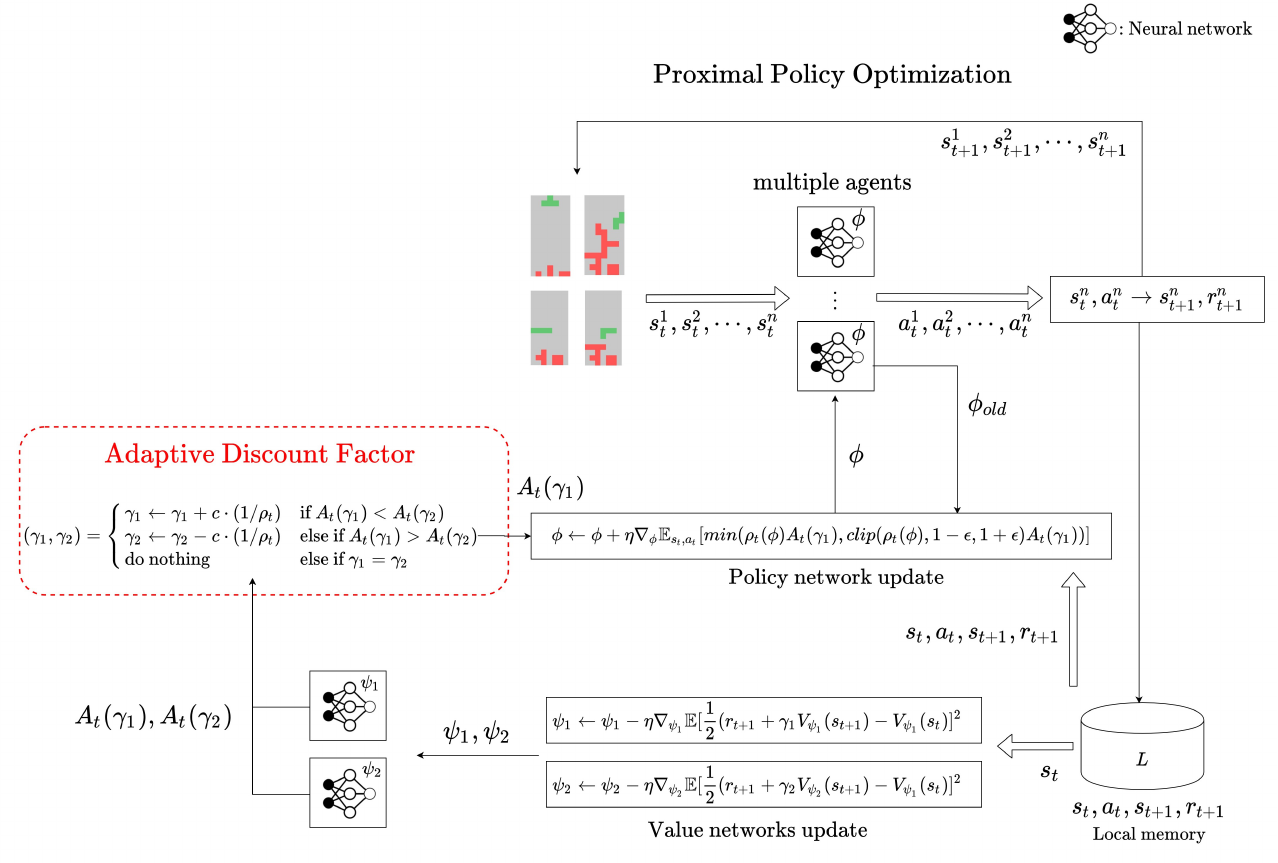
Figure 7. PPO with adaptive discount factor for the Tetris